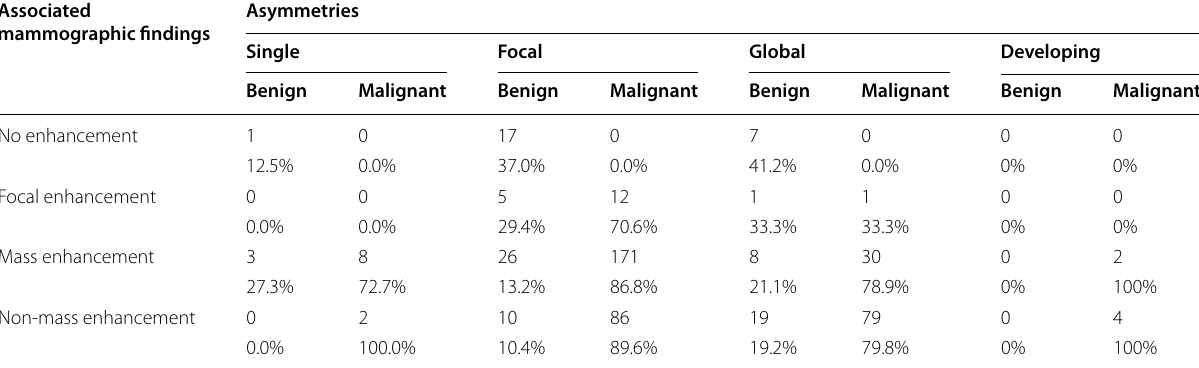
Table 3 The enhancement pattern of breast asymmetries and its correlation to the final diagnosis